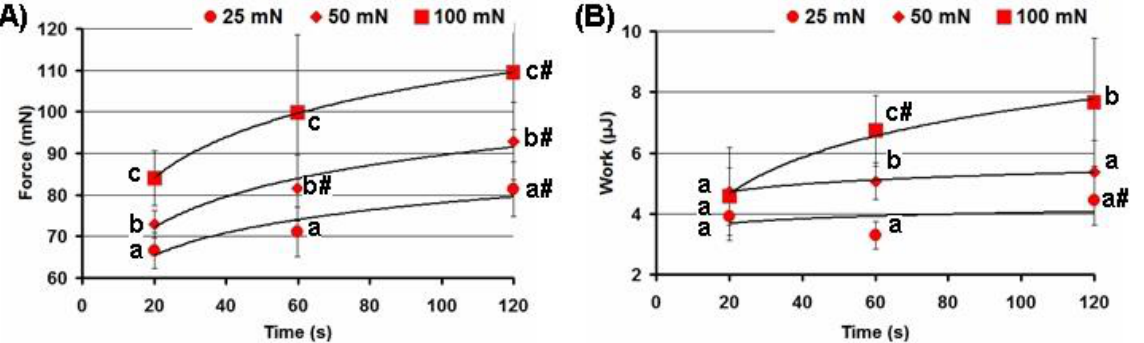
Figure 6. Effect of the time (20, 60, and 120 s) and force of compression (25, 50, and 100 mN) on the strength ( A ) and work of adhesion ( B ) of the FeP hydrogel to the serosa. Different lowercase letters indicate significant differences for the means of the different compression forces; #— p < 0.05 vs. the previous time point.